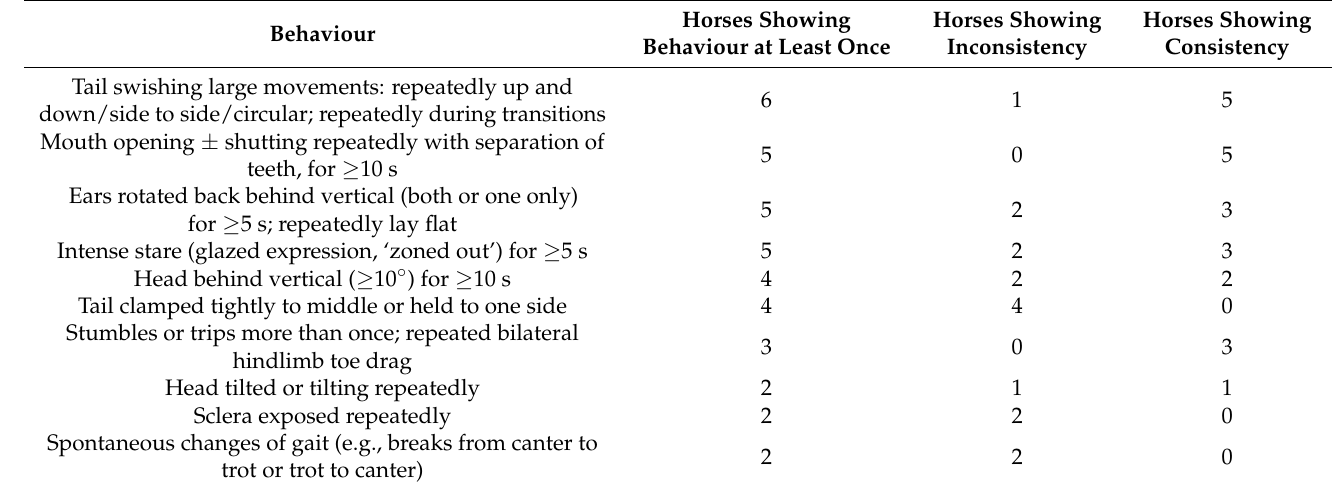
Table 2. Summary of the frequency and consistency of the ten most commonly observed behaviours of the Ridden Horse Pain Ethogram in six horses assessed at two Grand Prix dressage competitions. Behaviour